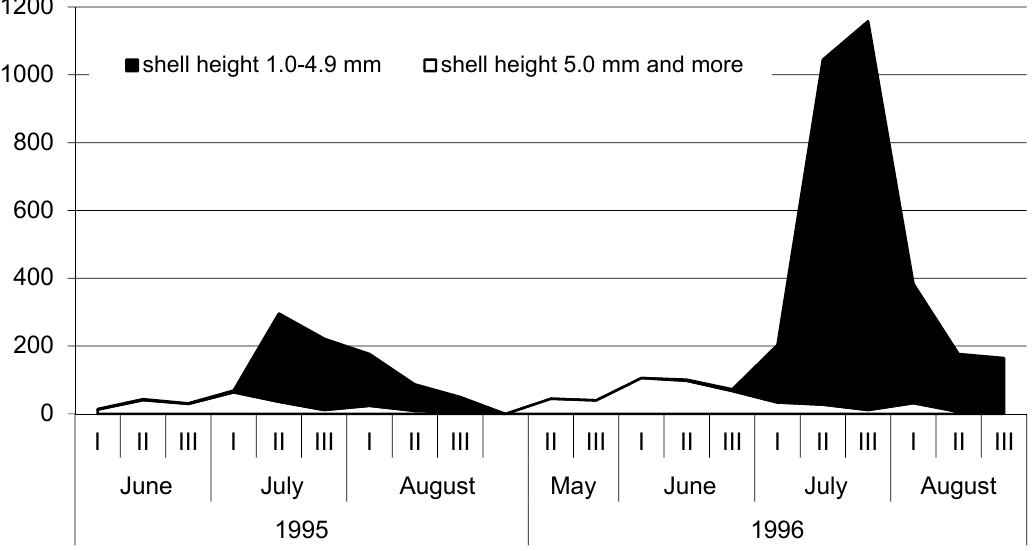
Figure 7. Seasonal dynamics of Bithynia troschelii abundance in the Kargat River estuary in